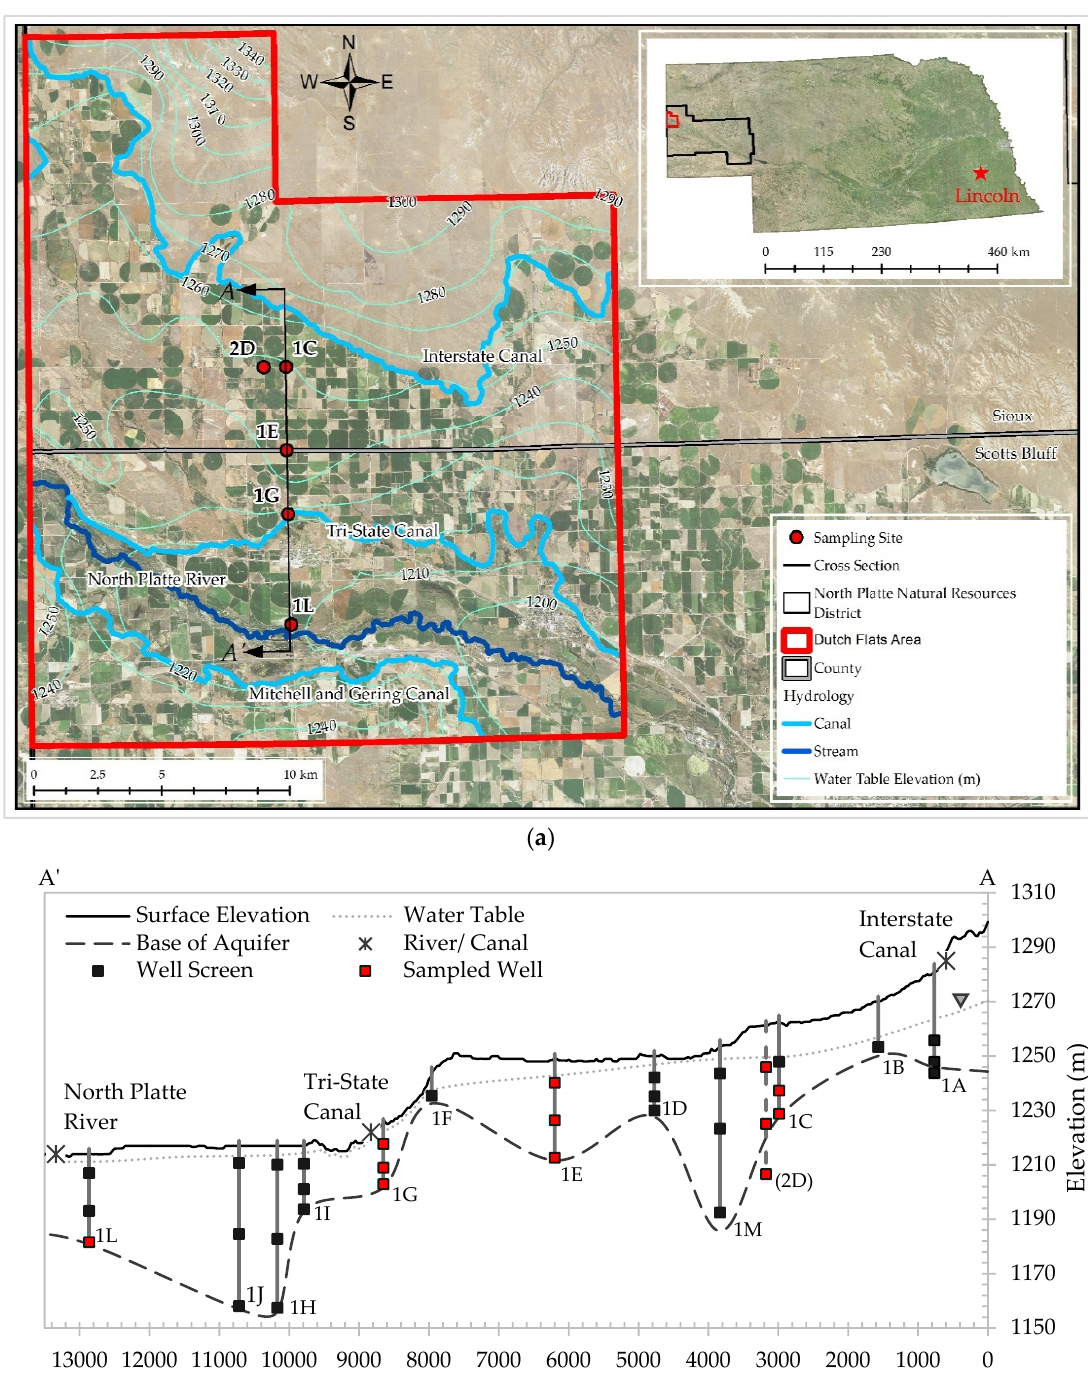
Figure 1. Site description: ( a ) location of Dutch Flats area within Nebraska’s North Platte Natural Resources District, including water table elevation contours [43]; and ( b ) representative cross-section along well transect with mid-screen elevations at each well nest. Elevations were derived from previous Dutch Flats studies [11,31]. Red well screens indicate locations where the current study collected groundwater samples. Site 2D, shown with a dashed line and in parenthesis, is situated behind 1C, or into the page, and is located above the base of aquifer in its respective location. A small feedlot is directly adjacent to Well 1G.